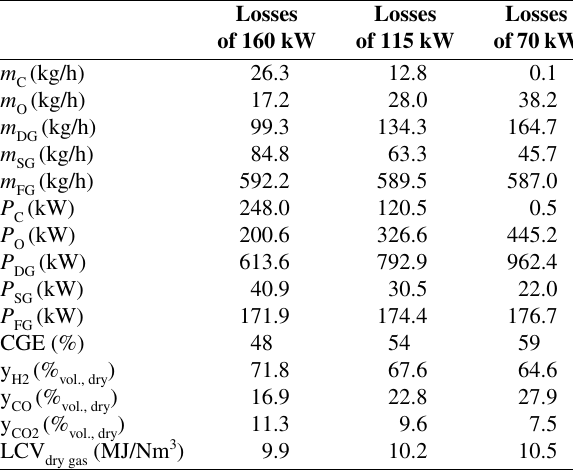
Table 4. Dry gas compositions, mass and heat flows as predicted by equilibrium model. For the flows of air 1, air 2, plastics, biomass and steam to gasification reactor refer to Fig. 3 .